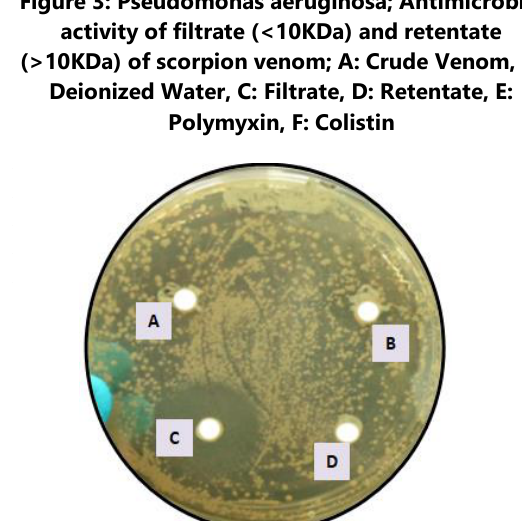
Figure 5: Acinetobactor baumannii; Antimicrobial activity of Crude venom by Agar-disc diffusion